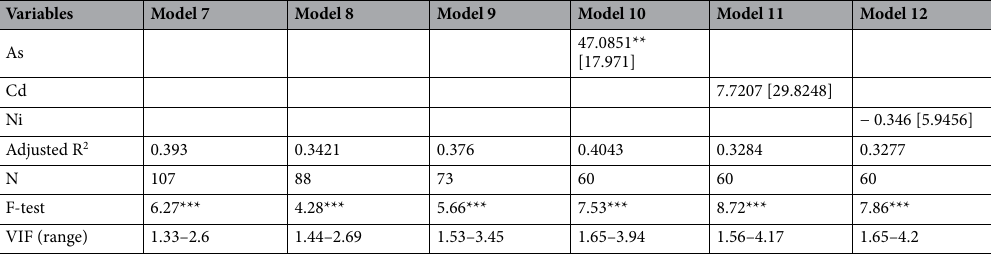
Table 10. Results from OLS models on COVID-19 excess mortality registered on 30 November 2020. p-value < 0.01***; p-value < 0.05**; p-value < 0.1*. Standard errors in parentheses. All models included a constant, a dummy for regional capitals, and controls for the size of the province, smokers, and obese